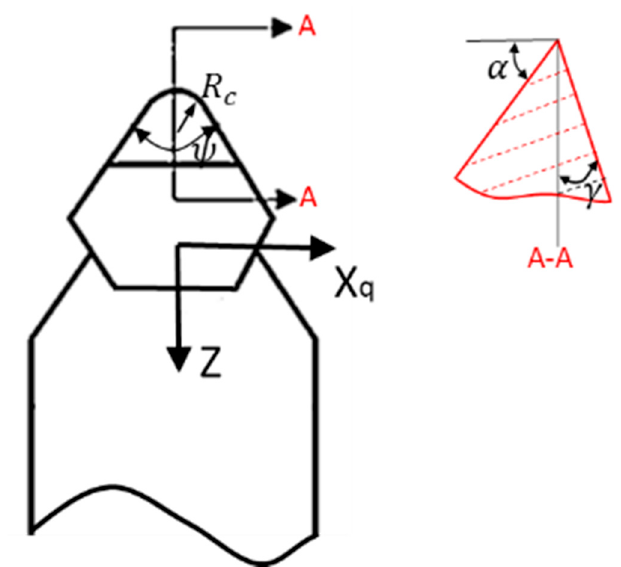
Figure 4. Geometric parameters of a typical diamond cutting tool.